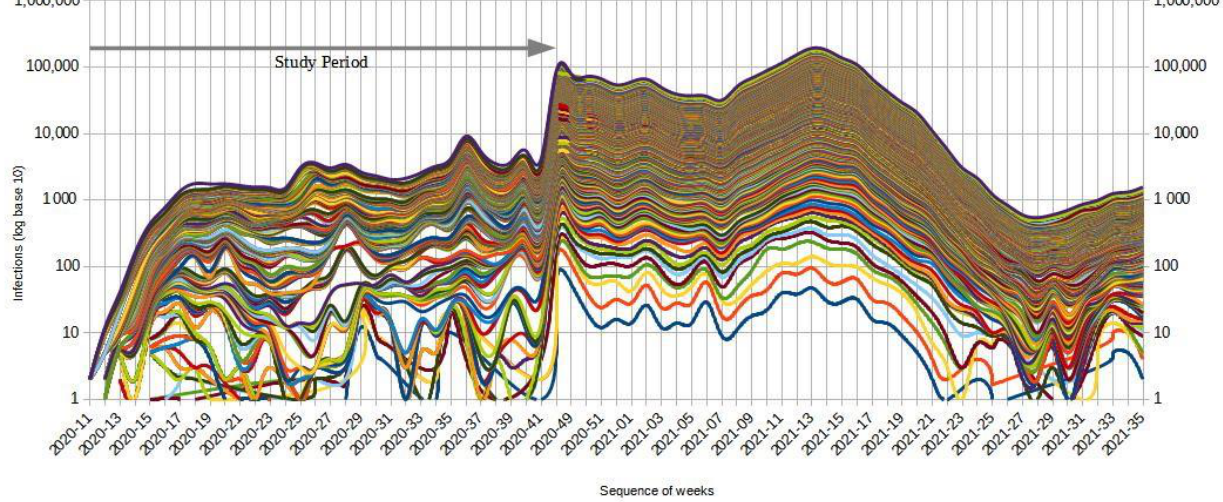
Figure 1. Stacked, cumulative number of infections by county in Poland per week (from March 2020 to July 2021; Study Period from weeks 11 to 41 of 2020); data source: Ministry of Health, Poland (counties are identified by statistical numbers, four-digit TERYT strings).